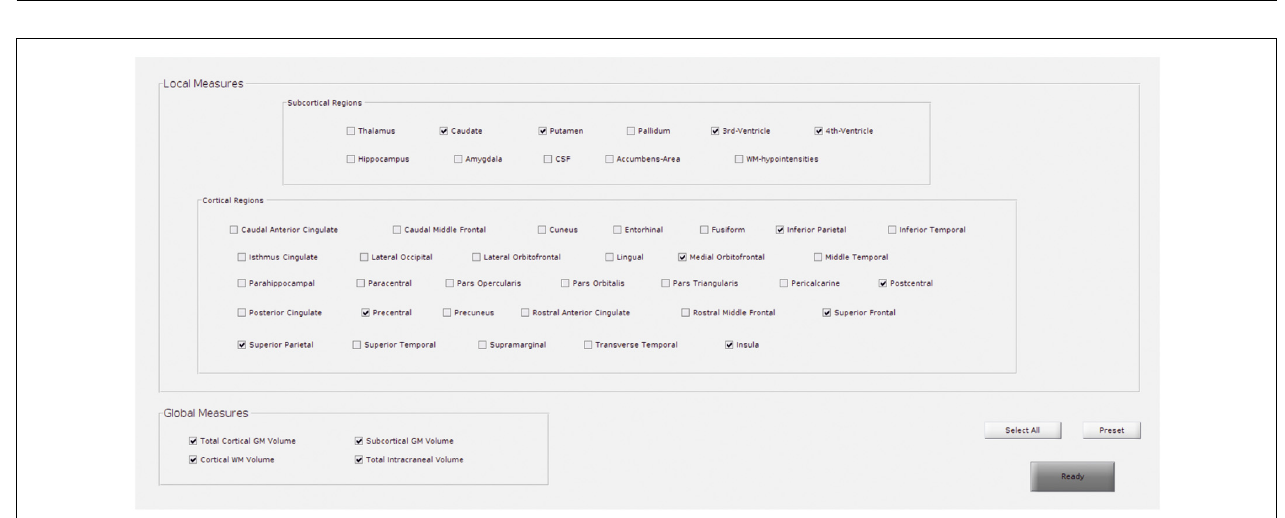
FIGURE 2 | GUI for the selection of regions to target in regions of interest (ROI)-based analysis. This example shows the predefined regions for Huntington’s disease (HD).